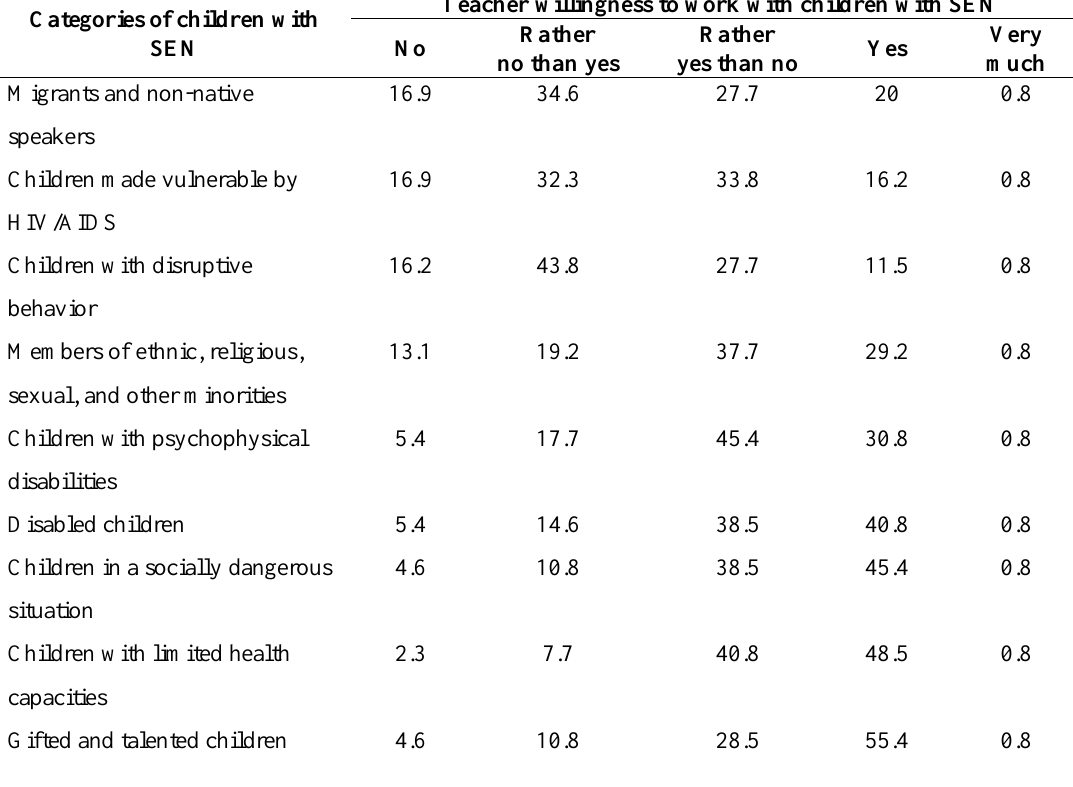
Table 1. Intensity of Teacher Willingness to Work with the Various Categories of Children with Special Educational Needs